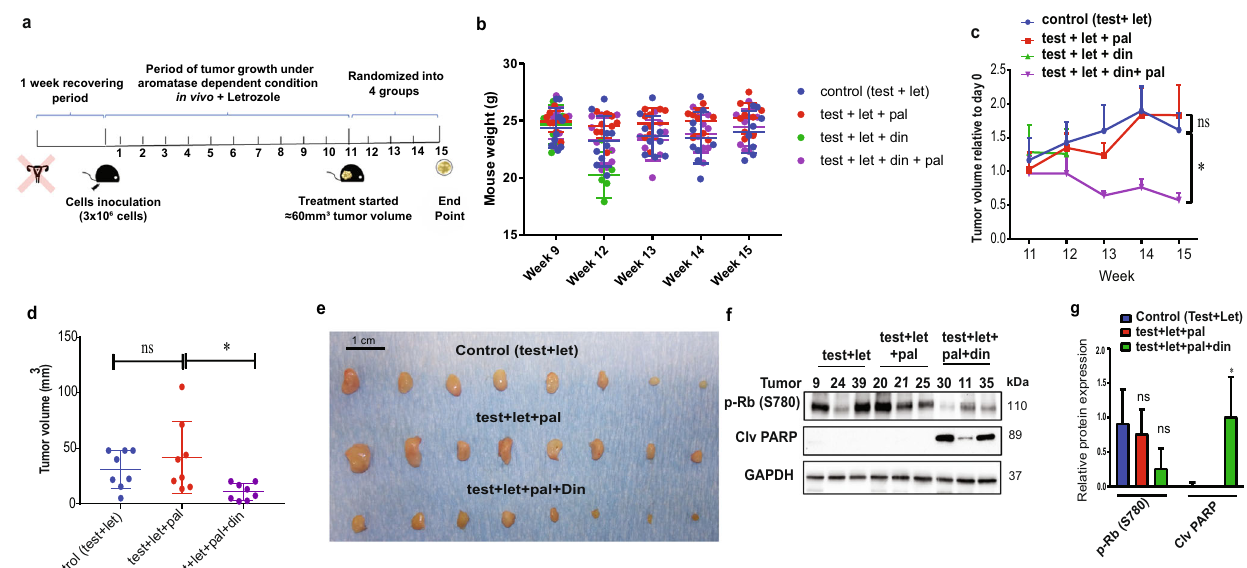
Fig. 6 Combined treatment with CDK2i, CDK4/6i, and AI suppresses autocrine estrogen-dependent growth of BC tumors in a postmenopausal xenograft model. a Scheme by week showing the protocol of the in vivo model simulating postmenopausal BC patients with autocrine estrogen-dependent tumors. b Mouse bodyweights were measured at week 9 and then weekly from week 12. c , d Orthotopic LetR3 tumors grown in the presence of 250 μ g testosterone (test) + 10 μ g letrozole (let) were randomized to 4 groups ( N = 8 per group); control (250 μ g test + 10 μ g let), 12.5 mg/Kg CDK4/6i palbociclib (pal), 10 mg/Kg CDK2i dinaciclib (din), 12.5 mg/Kg pal + 10 mg/Kg din. Test + Let were administered to all treatment groups by subcutaneous injection in 0.5% carboxymethylcellulose (CMC), palbociclib was administered by oral gavage in 25% HP-beta-cyclodextrin (HPC), and dinaciclib was administered intraperitoneally (IP) in 5% HPC. All drugs were administered daily for 5 weeks. Mice from test + let + din group were sacri fi ced after 1 week of treatment due to toxicity. c Tumor growth curve relative to the treatment starting point (week 11). d Tumor volume at the endpoint of treatment (week 15). Data are shown as mean tumor volume ± SEM and the p -values are calculated using one-way ANOVA test at the endpoint of the treatment e Picture of the resected tumors. f Western blotting analysis of cell cycle arrest and cell death markers in lysates from three tumors of each treatment group. GAPDH was used as loading control. g Densitometry analysis of western blotting bands from three different tumors of each group was performed using ImageJ software and normalized to GAPDH. Data are shown as mean area under the curve (AUC) normalized to the loading control ± SD. Statistically signi fi cant differences calculated by one-way ANOVA are shown as ns >0.05, *p ≤